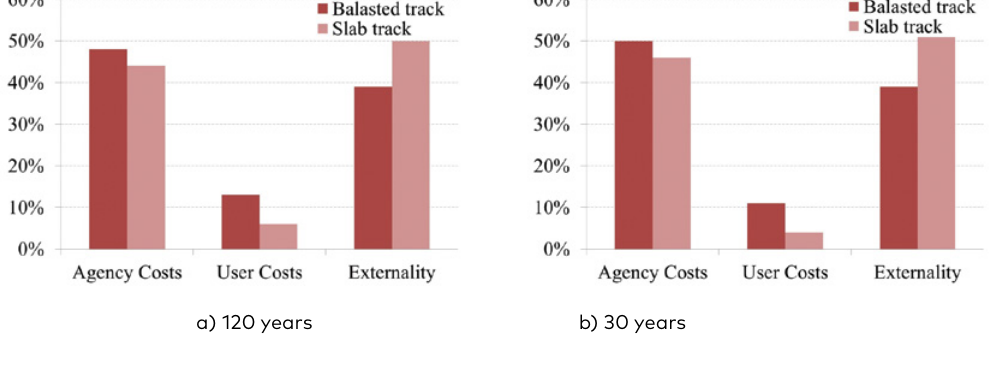
Figure 6. Classes of costs for the two